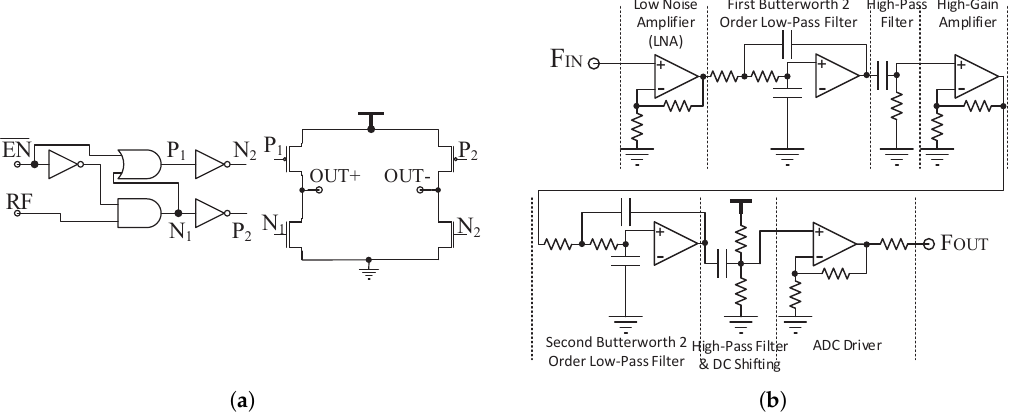
Figure 11. ( a ) The circuit diagram of the in-body uplink PA; and ( b ) the circuit diagram of the out-body uplink filter